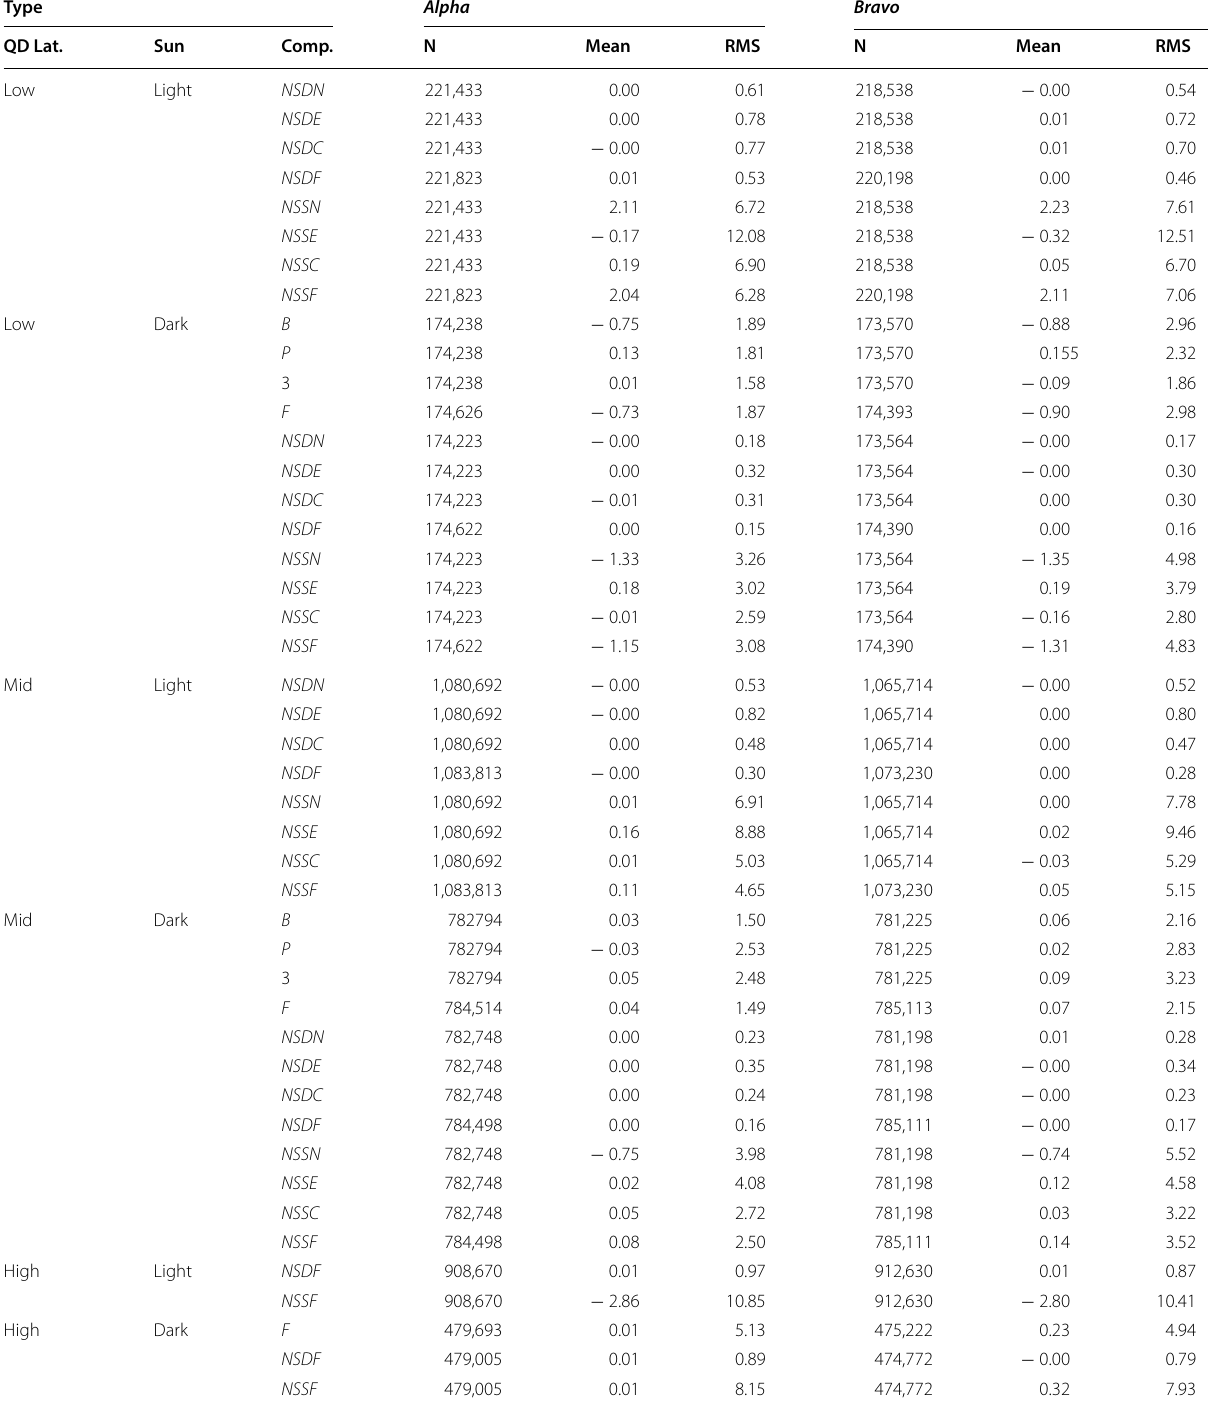
Table 6 CM6 weighted residual statistics for Swarm Alpha and Bravo , where “QD” denotes Quasi-Dipole, “ NS ” denotes North–South along-track, “ DF / SF ” denotes scalar differences and sums, respectively, “ DN / SN ”, “ DE / SE ”, and “ DC / SC ” denote vector differences and sums in the local North-East-Center frame, respectively, “ F ” denotes scalar, and “ B ”, “ P ”, and “3” denote vector measurements in the HB-theory frame,